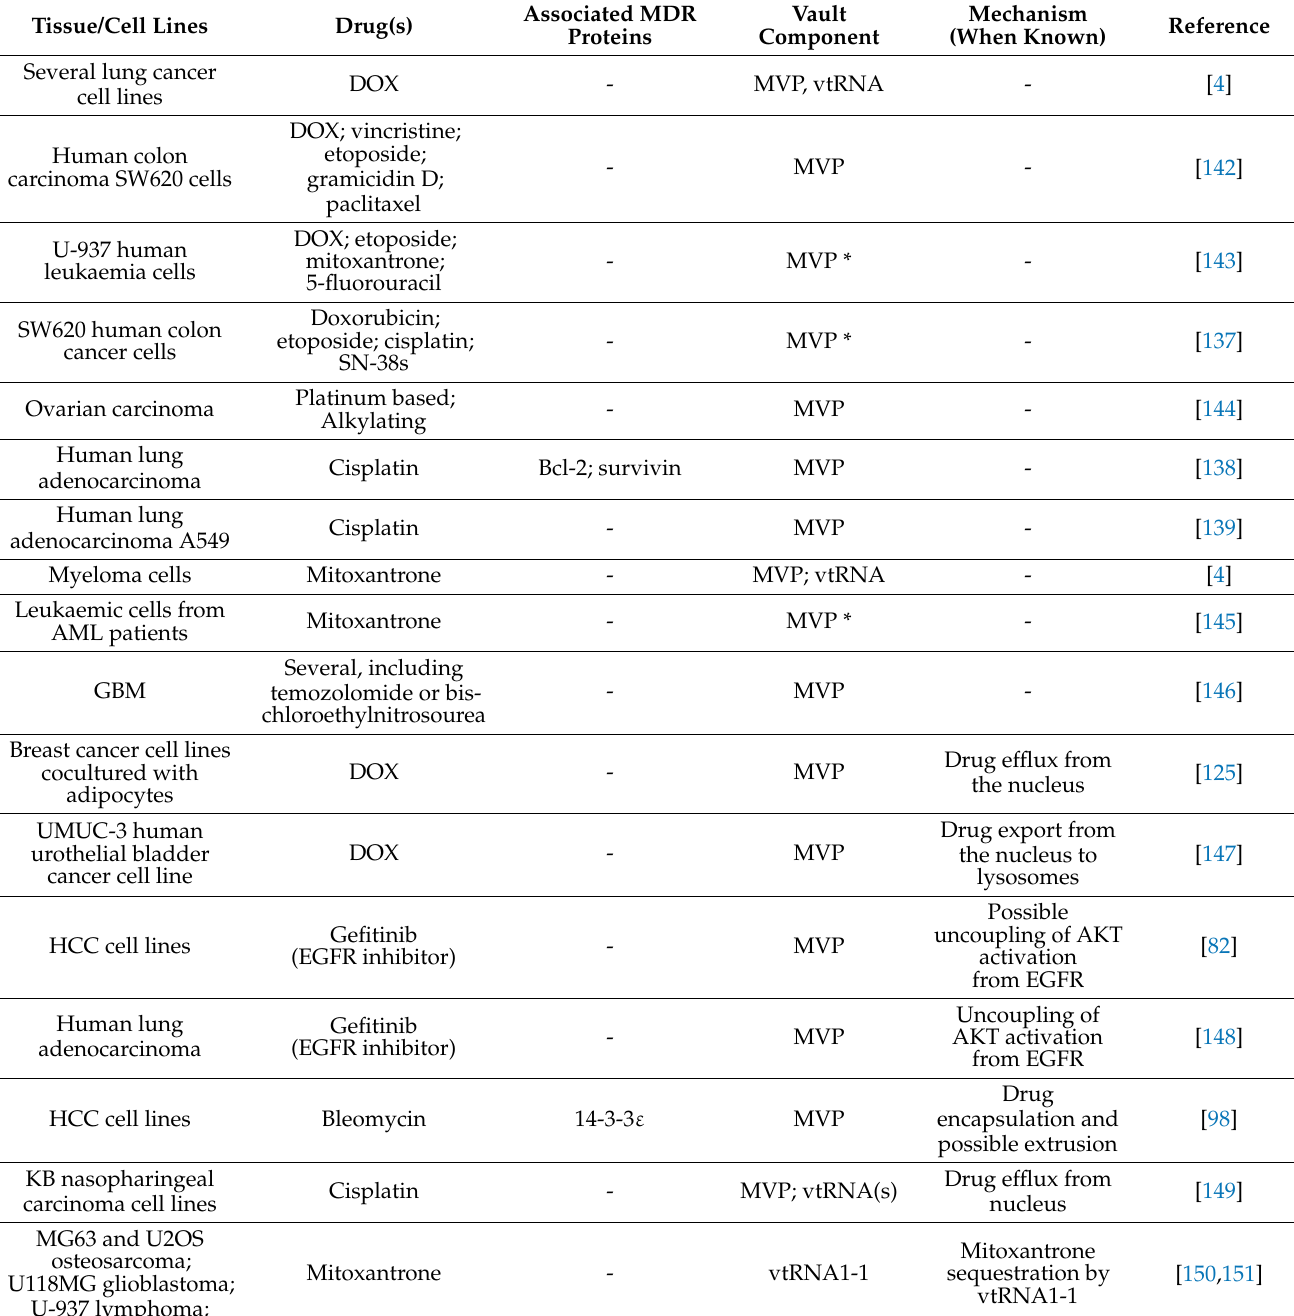
Table 3. Multidrug resistance associated with vault overexpression and related mechanisms when